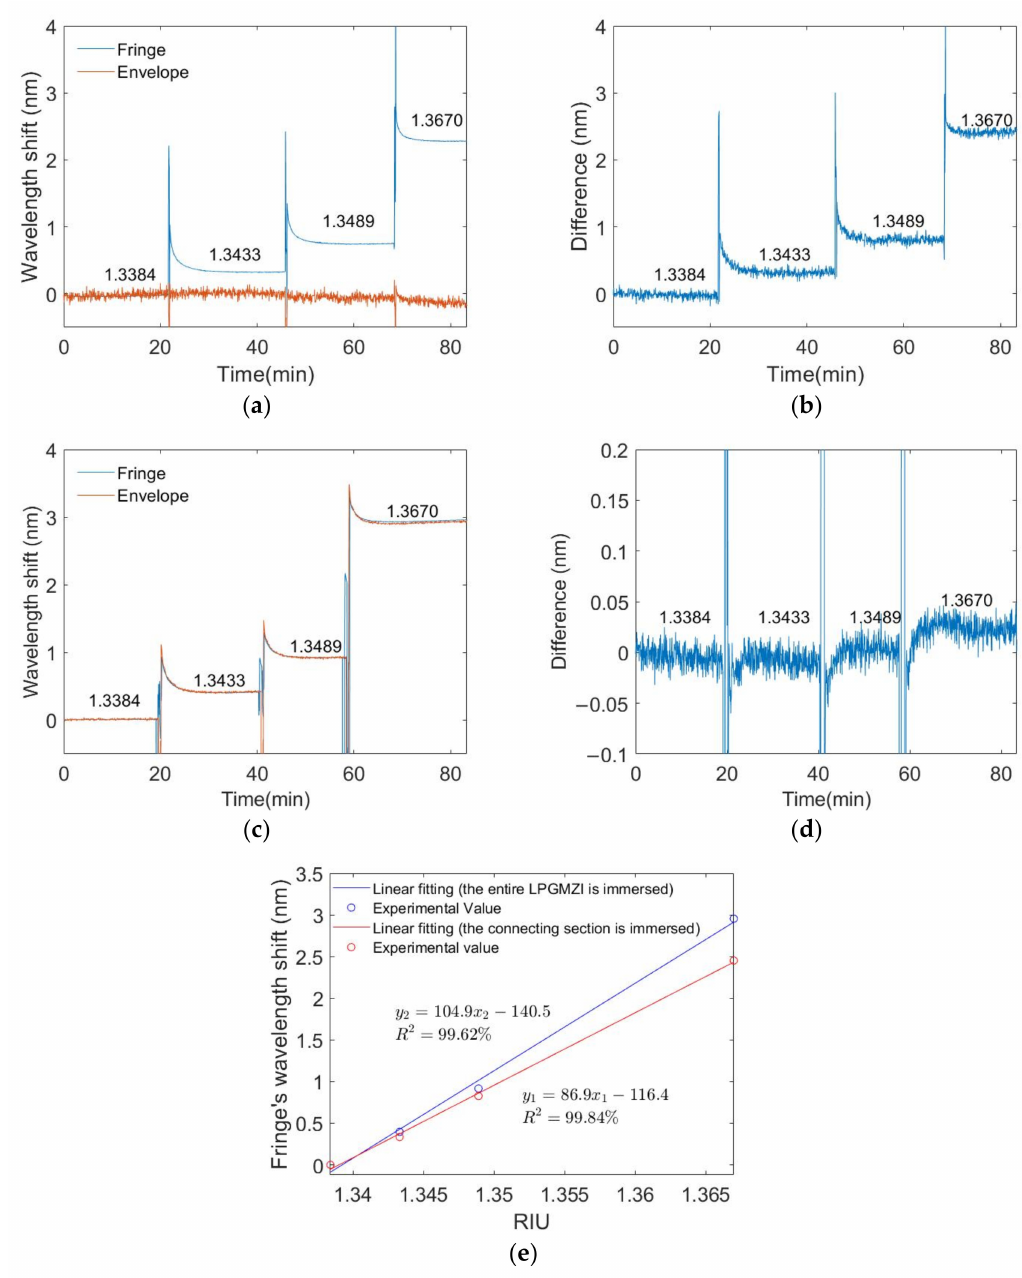
Figure 7. External RI measurements: ( a ) Wavelength shifts of fringes and envelope when the connecting section is immersed in RI solutions and ( b ) their difference. ( c ) Wavelength shifts of fringes and envelope when the entire LPGMZI is immersed in RI solutions and ( d ) their difference. ( e ) Calibration curve of the fringes’ wavelength shifts in those two different